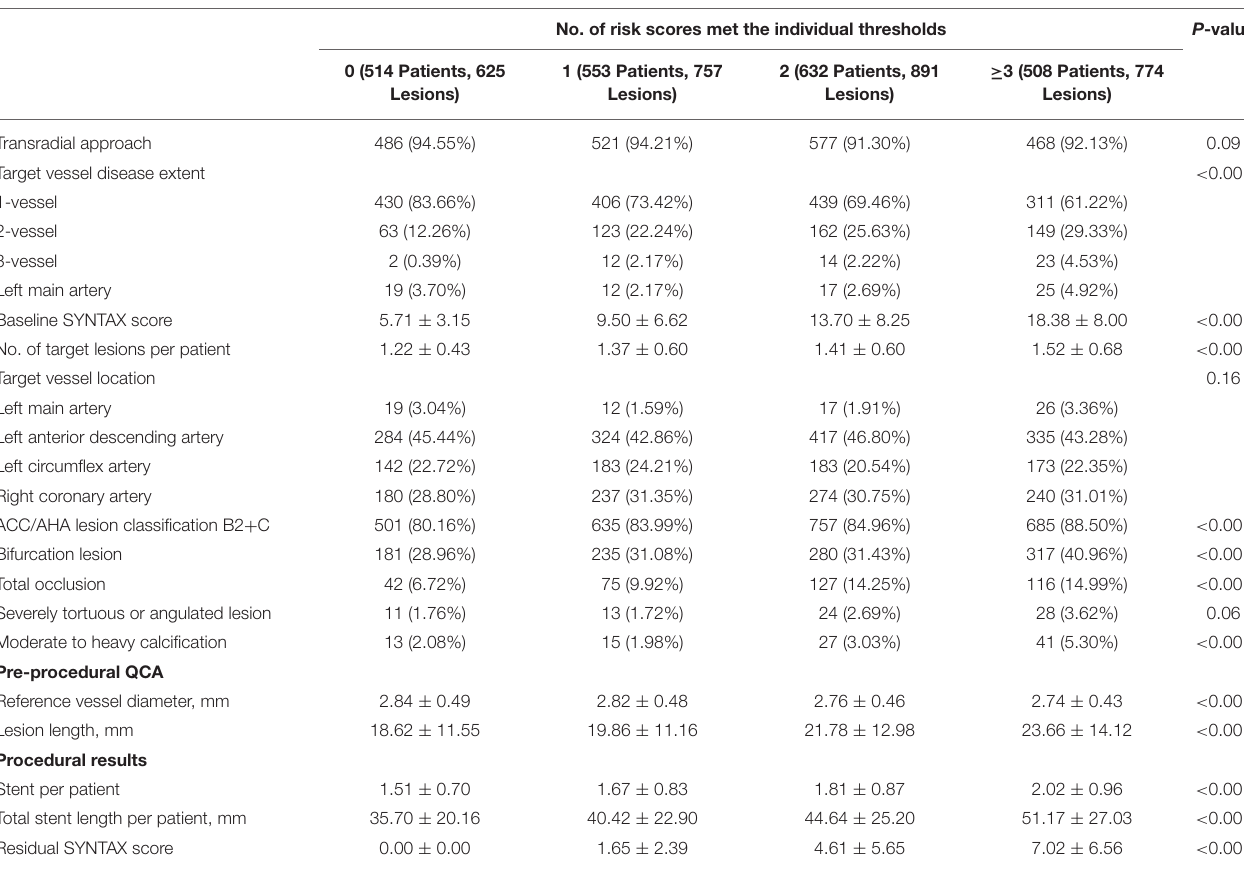
TABLE 2 | Lesion characteristics and procedural results stratified across cumulative risk-score